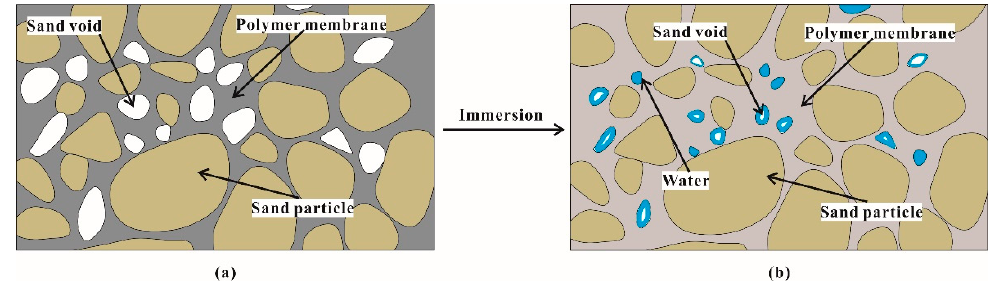
Figure 3. The schematic diagram of the polymer-sand composite material for different periods: ( a ) Before immersion; ( b ) After immersion.